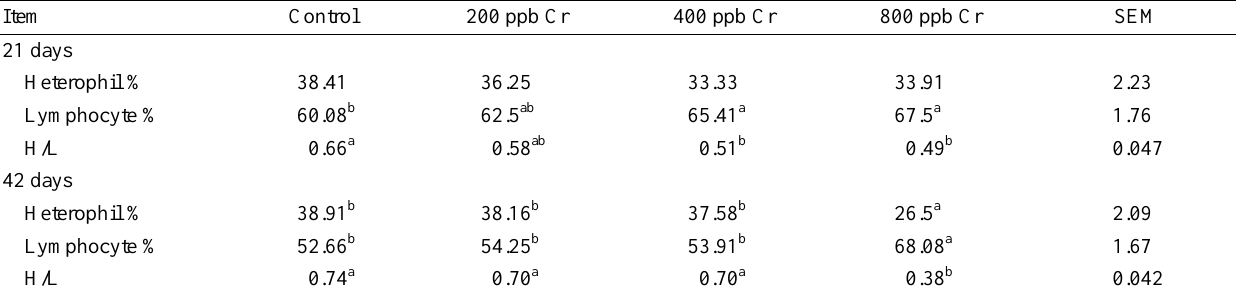
Table 3. Effect of chromium supplementation on heterophil and lymphocyte count and ratio (H/L)